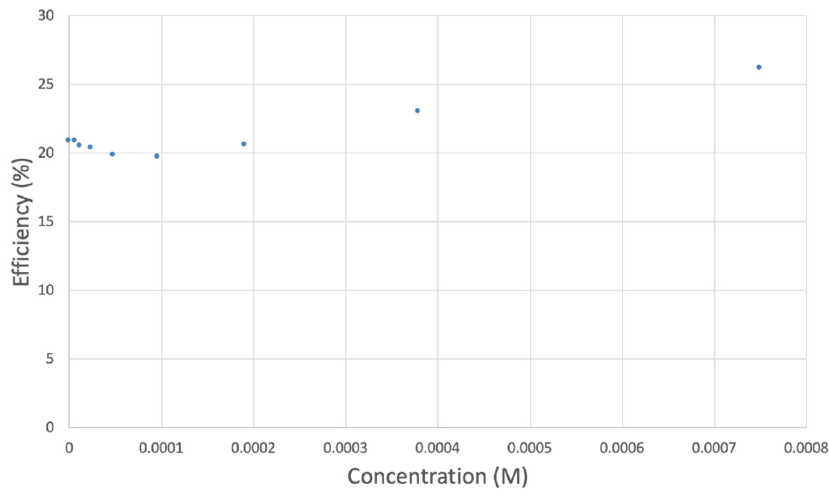
Figure 8. TQ efficiency.